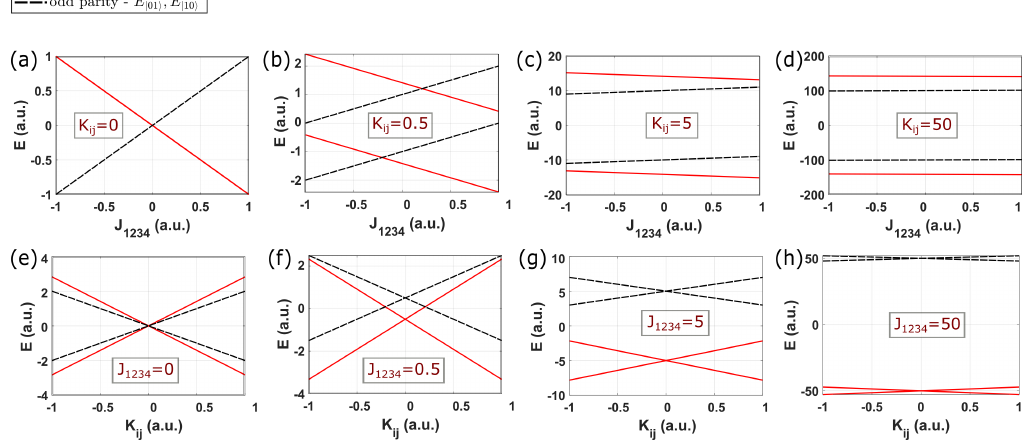
Figure 2: (Top row) Energy levels of the Hamiltonian in Eq. (4) as a function of J , fixing all K ’s equal to a constant - (a) K ij 1234 = 50. (Bottom row) Energy levels as a function of K (d) K ij varied simultaneously), fixing J equal to a constant - (e) J 1234 = 5. (f) J = (g) J 1234 1234